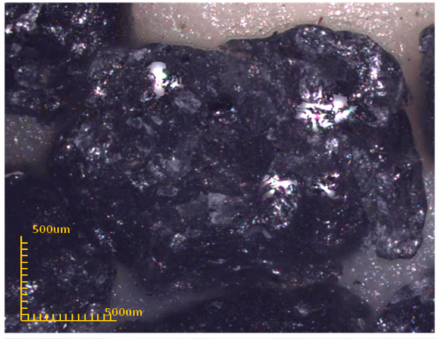
Figure 4. SSPCM particles.